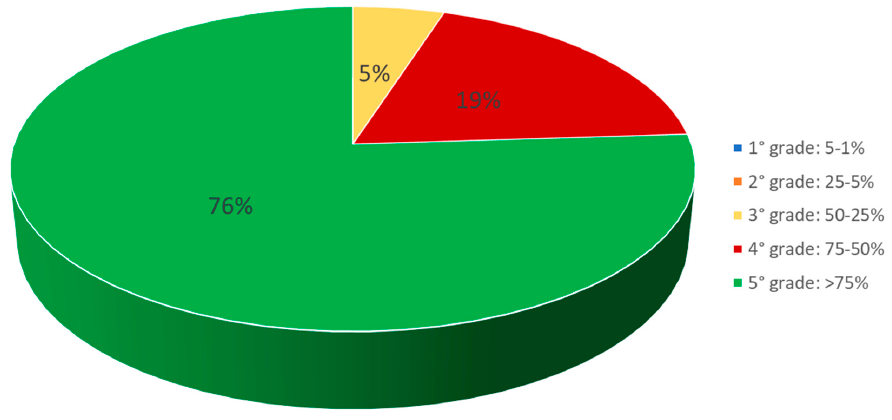
Figure 3. Grades of organisms’ coverage on the marine litter.